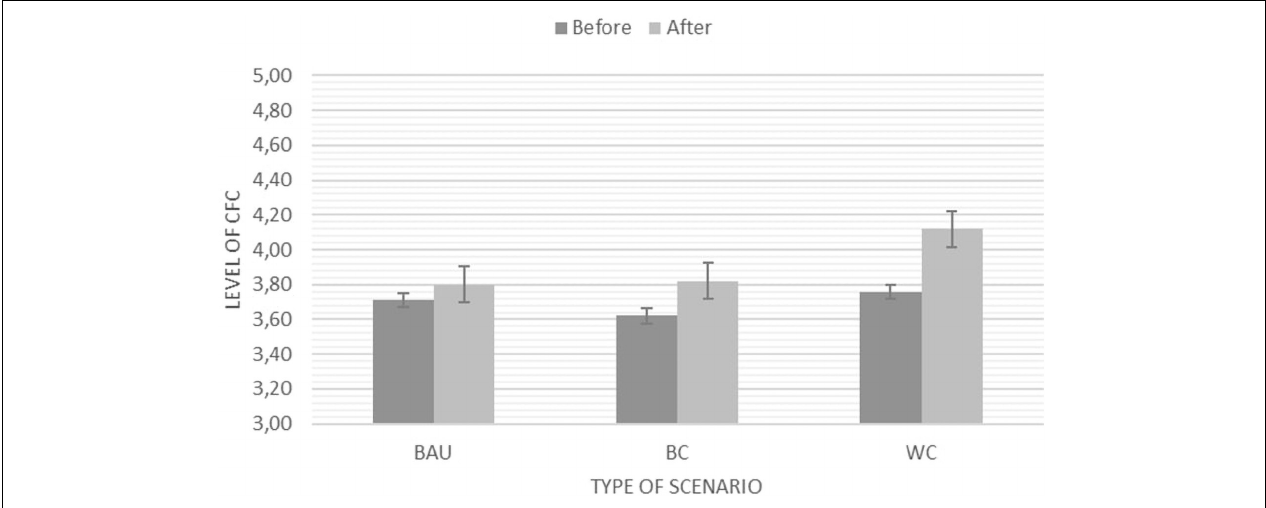
FIGURE 6 | Estimated marginal means for CFC before and after the creative engagement with three different types of scenarios: BAU, Business as Usual; BC, Best Case Scenario; and WC, Worst Case Scenario. NB: Y -axis adapted for illustration purposes. The Likert scale ranges from 1 ( Strongly disagree ) – 5 ( Strongly agree ).